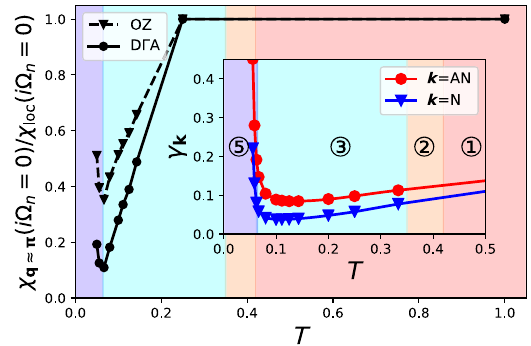
FIG. 22. Main panel: relative contributions to the AF suscep- tibility from wave vectors in the vicinity of Q ¼ ð π ; π Þ for D Γ A (solid line, black circles) and the Ornstein-Zernike fit (dashed line, black triangles) as a function of T . Inset: For completeness, γ Γ A is shown for the different regimes as a function k from D of temperature for the antinode (red circles) and node (blue